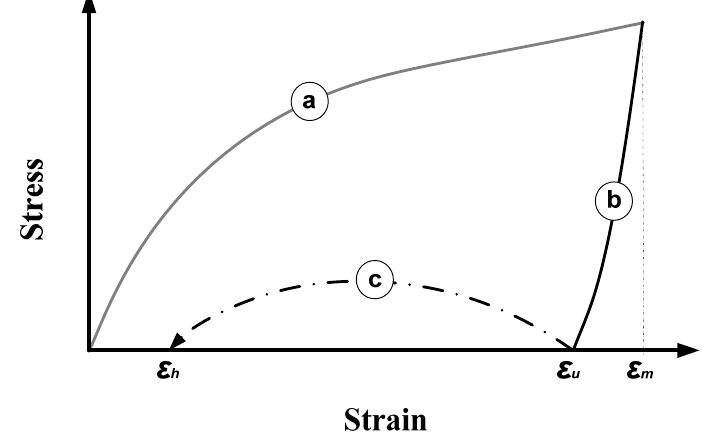
Figure 4. Illustration of a typical SME cycle in heating-responsive